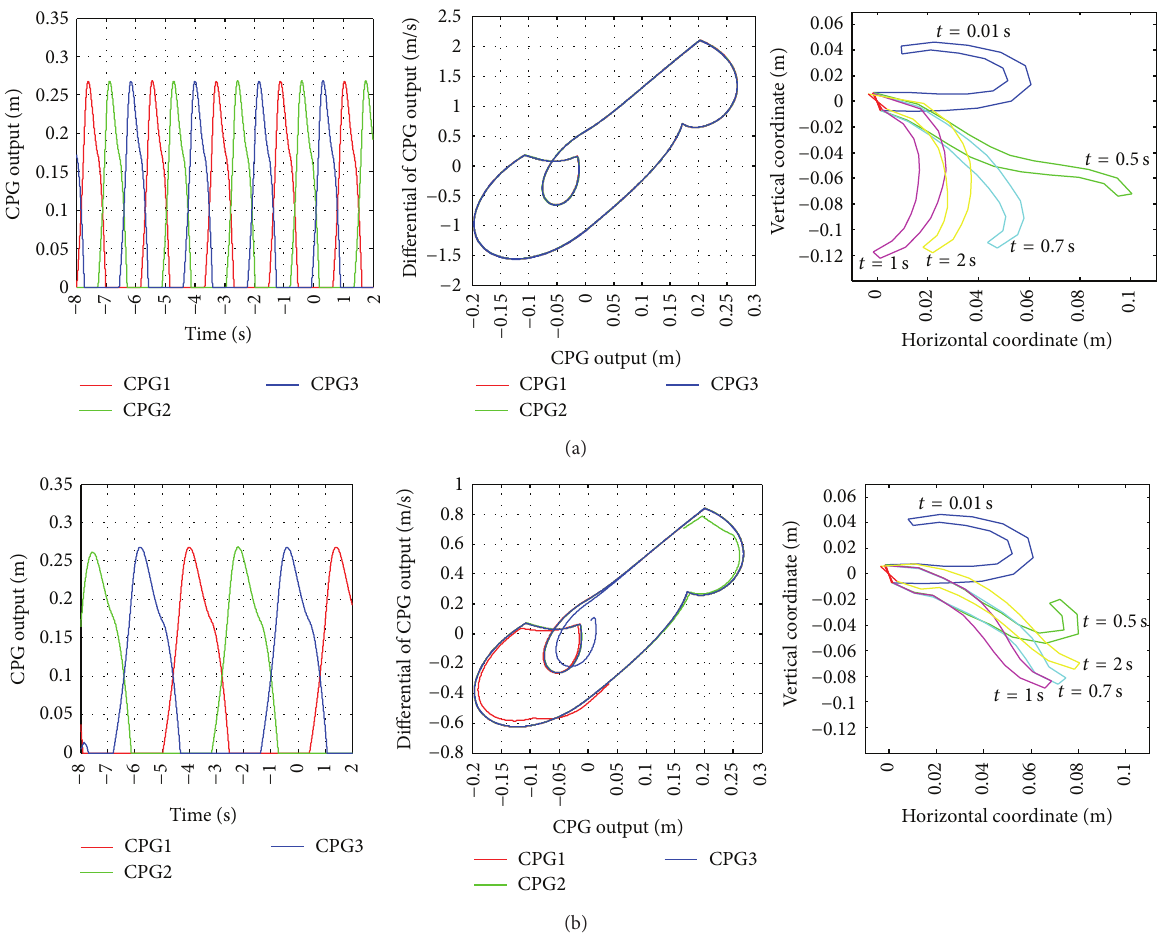
Figure 6: Outputs and phase diagrams of three coupled CPGs and a sequence of octopus arm movements with the parameter 𝑇 𝑟 (from left to right): (a) 𝑇 𝑟 = 0.2 and (b) 𝑇 𝑟 = 0.5